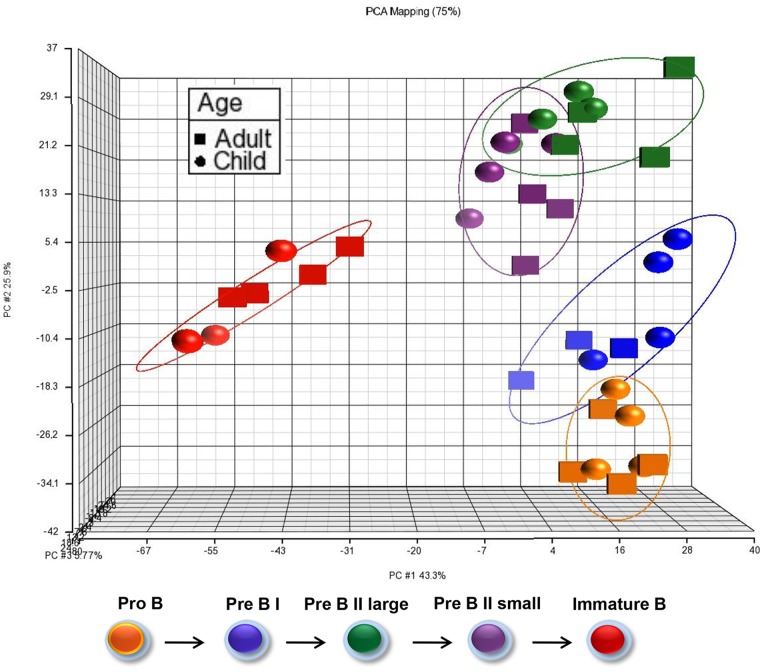
Principle component analysis (PCA) of regulated genes.The clustering represents the overall expression pattern of significantly regulated mRNAs at FDR 0.1% (p-value ≤1.13×10−4) in five subsets of precursor B cells. Color codes represent the various maturation stages as indicated under the plot. The Partek® Genomics Suite™ program draws the elipsoids encompassing the individual datapoints. Note the dots for the children (spheres) and adults (angular balls) are tightly grouped together.